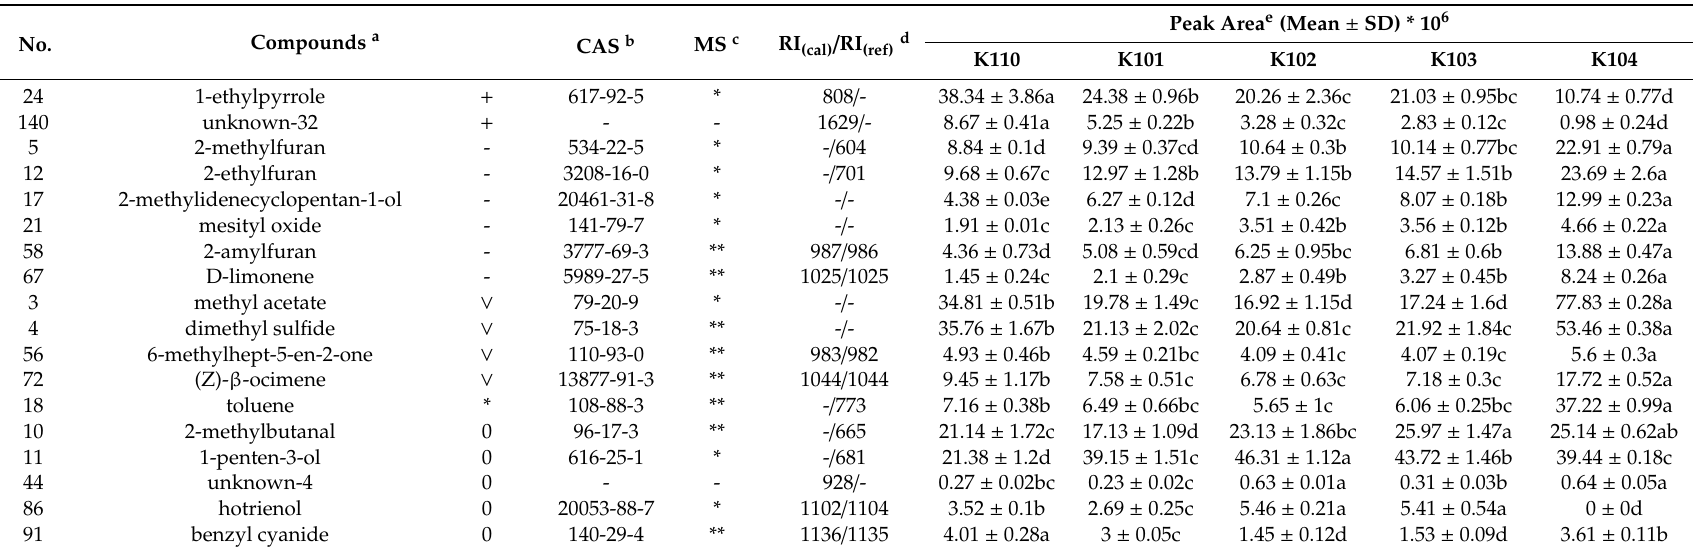
Table 2. Information about 18 di ff erent